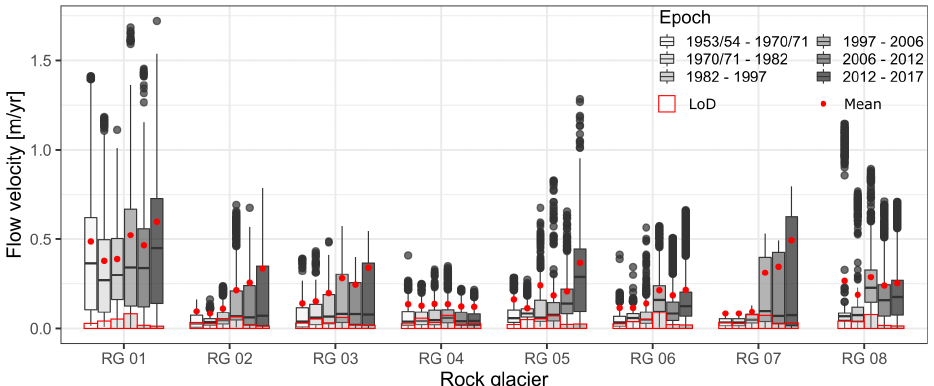
Figure 6. Flow velocities for individual rock glaciers for six distinct epochs from 1953 to 2017. Rock glacier RG09 was not included in the flow velocity analysis, and rock glacier RG 08 had to be excluded from epoch 1 due to extensive decorrelation in the frontal part because of large displacements. The mean value (red dot) was calculated for values above the maximum LoD of the respective rock glaciers. The respective LoDs of the epochs are shown as red boxes. The black dots represent outliers, which by definition are located at least 1.5 times the box length (interquartile range) above the